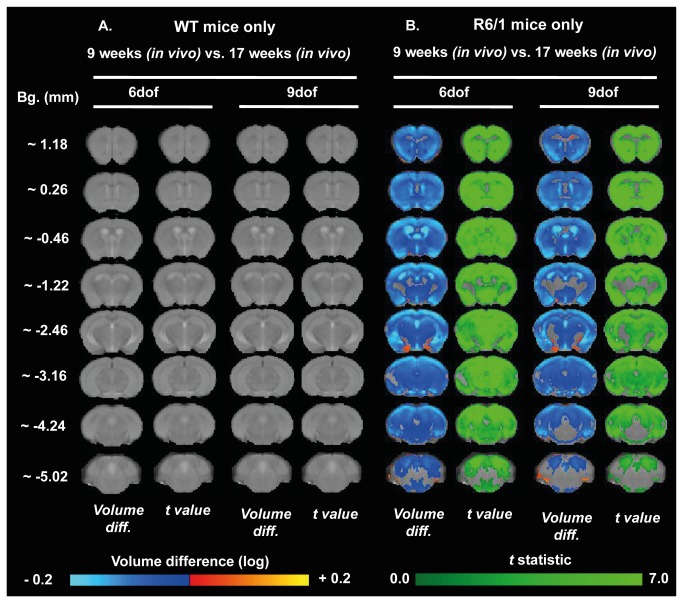
Age-related evolution of brain atrophy in female mice measured through TBM.Maps of local volumetric change in both female WT (A) and female R6/1 mice (B) between the two time points (9 and 17 weeks of age). Images presented as either global volume change (6 dof) or regional-specific changes corrected for global change (9 dof). Color scales are for volume difference (Volume diff., blue-to-yellow) and the raw t statistical value at each voxel (dark-to-light green). Only volume changes and effects-sizes which survive multiple comparisons corrections across all voxels in the brain (False Discovery Rate with q<0.05) are shown.